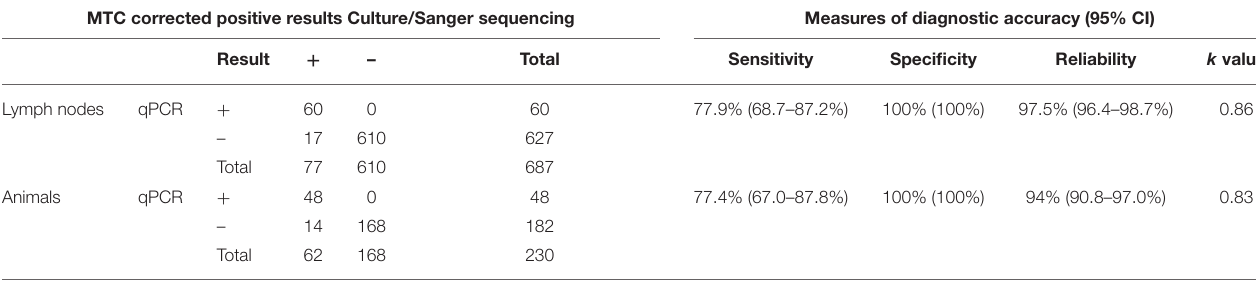
TABLE 3 | Validation of direct qPCR targeting IS 6110 for the detection of MTC analyzing 687 lymph nodes belonging to 230 cattle. MTC corrected positive results Culture/Sanger